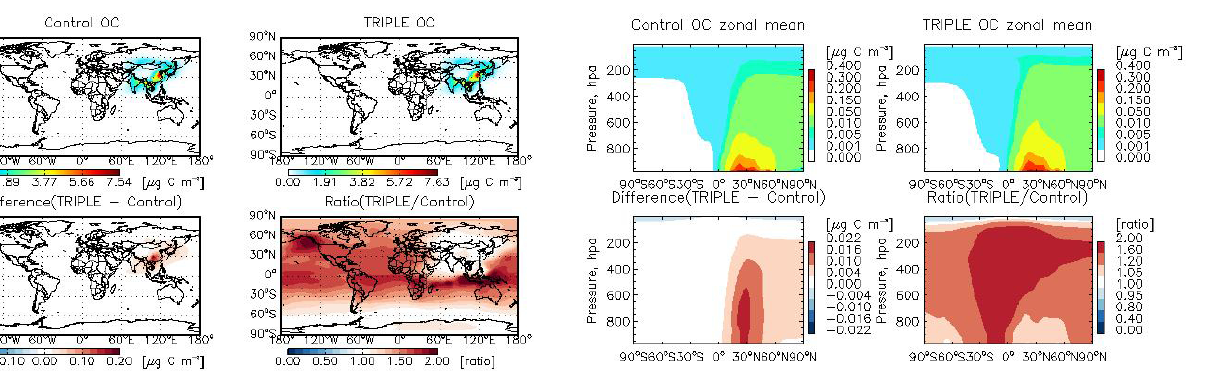
Fig. 11d. Same as Fig. 11b but for zonal